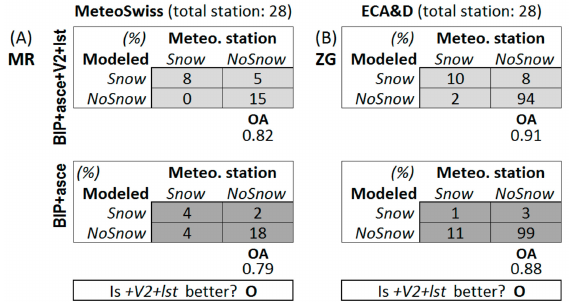
Figure 5. Confusion matrix of the ( a ) Monte Rosa (MR) and ( b ) Zugspitze (ZG) regions validated with meteorological snow depth (SD) station data records of MeteoSwiss and the European Climate Assessment and Dataset Project (ECA&D), respectively. The summary of improvement depicts the improvements achieved by adding vegetation indexes and temperature information: “OO” for major improvement, “O” for slight improvement, “-“ for no change, “X” for slight degradation, and “XX” for major degradation. The confusion matrixes marked in light and dark grey colors represent the results of using the present and previous [18] variable combination,